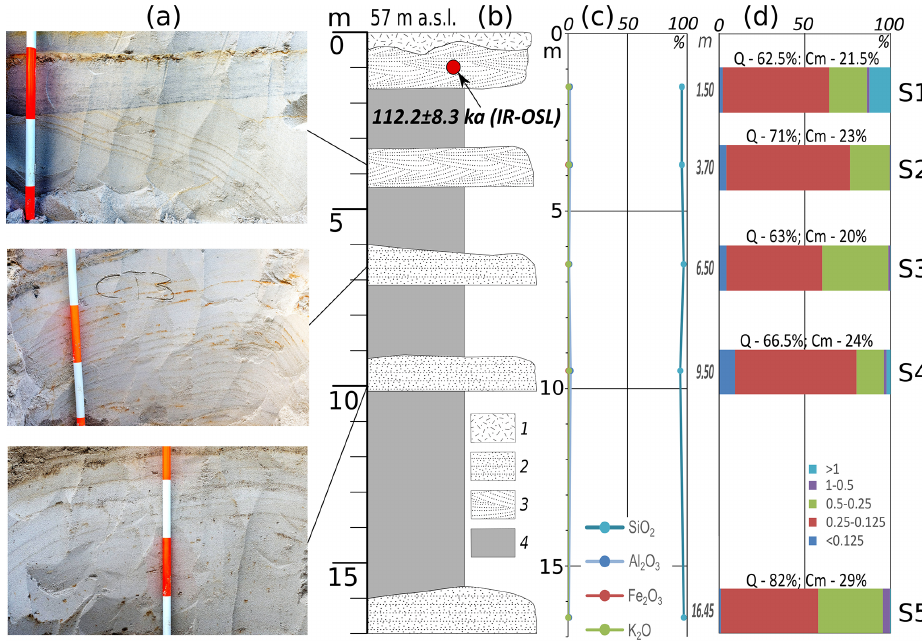
Figure 6. Summary results of research for section NS-20: (a) photographs (by Sizov in 2018); (b) geological structure and the dating results (see Table 3); (c) bulk chemical data; (d) grain size distribution (fractions,mm). Symbols: (1) overburden; (2) horizontally layered sand; (3) medium- and coarse-grained oblique sand; (4) colluvium; Q : coefficient of roundness of the sand quartz grains; Cm: degree of dullness; S: sample number.